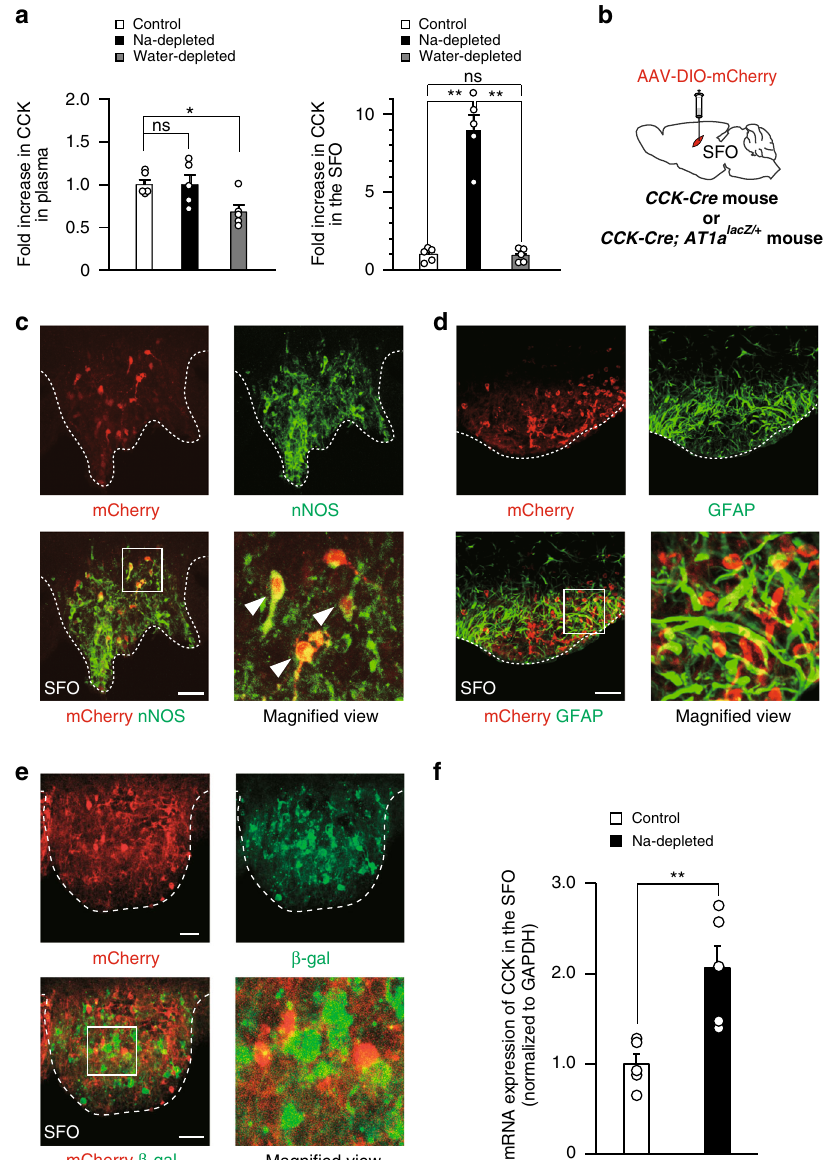
Fig. 1 CCK-positive neurons in the SFO are AT1a-negative excitatory neurons. a CCK levels in plasma (left) and the SFO (right) of mice under control, Na-depleted, and water-depleted conditions ( n = 5 samples each; left graph, U (Na) = 12, P = 0.917; U (Water) = 22, P = 0.047; right graph, U (Na) = 25, P = 0.009; U (Water) = 15, P = 0.676; U (Na vs. Water) = 25, P = 0.012). The right fi gure was reproduced from ref. 25 . b Injection of AAV-DIO-mCherry into the SFO of the CCK-Cre or CCK-Cre; AT1a lacZ/ + mouse. c – e Immunohistochemical detection of mCherry and nNOS ( c ), GFAP ( d ), and β -gal ( e ) in the SFO. The squared area in the merged panel was shown as the magni fi ed view. Arrowheads indicate double-positive cells. These images were reproduced from more than three independent mice. f mRNA expression of CCK in the SFO under the control and Na-depleted conditions ( n = 5 samples each; U = 0, P = 0.008). Scale bars, 50 µ m. ** P < 0.01; * P < 0.05; ns, not signi fi cant; two-sided Mann – Whitney U tests in ( a ) and ( f ). Data represent the mean ± showing that the activity of water neurons in the SFO was sup- activities of these GABAergic neurons were stimulated by CCK, pressed by GABAergic neurons in a CCK-dependent manner 25 . and suppressed by the CCK-B receptor antagonist, L-365,260 To con fi rm these results, we conducted electrophysiological (Fig. 2d). Furthermore, 53.1 ± 6.52% of GABAergic neurons in experiments using acute brain slices containing the SFO: brain the SFO were positive for CCK-B receptors (Fig. 2e). slices were prepared from CCK-Cre ; GAD67-GFP mice in which the SFO had been injected with AAV-DIO-mCherry. In these slices, GABAergic and CCK-positive neurons were identi fi ed by green (GFP) and red (mCherry) fl uorescence, respectively (Fig. 2c). In a subset of GABAergic neurons innervated by CCK-positive neurons (6/14 cells), we observed excitatory postsynaptic currents (EPSC), which were blocked by the AMPA glutamate receptor antagonist, CNQX (Fig. 2c). The fi ring